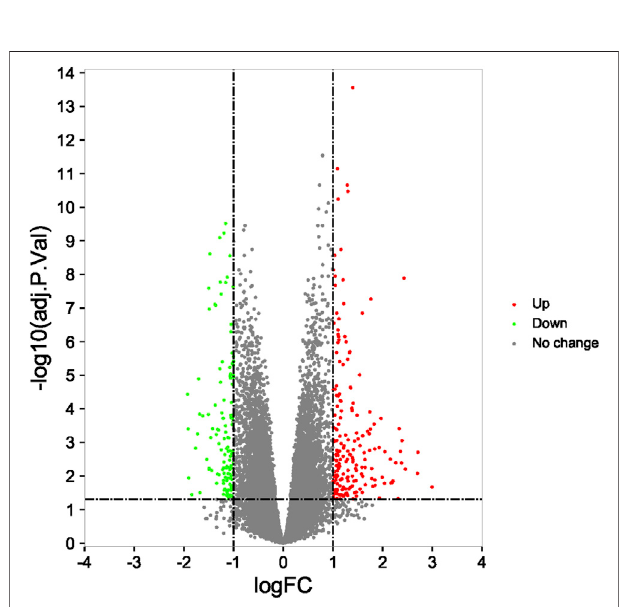
FIGURE 4 | Identi fi cation of differentially expressed genes and enrichment analysis. The 325 differentially expressed mRNAs in GSE111974.